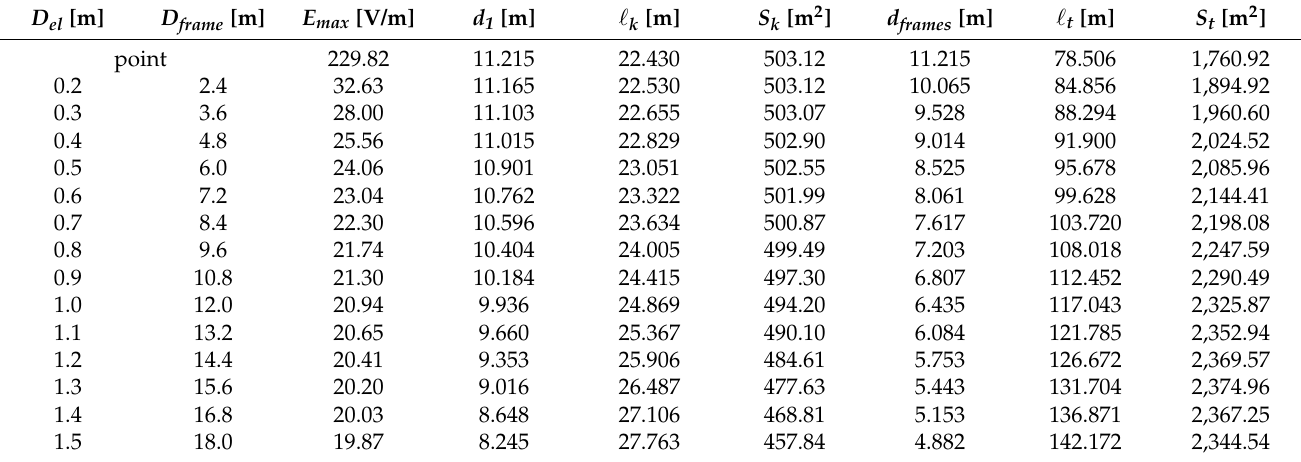
Table 10. Simulation results with method “C”, of linear current source for a linear frame of 13 electrodes for the area of Korakia ( ρ S = ∞ , without dam, L = 2.13 m, ρ w = 0.25 Ω · m, θ = 248 ◦